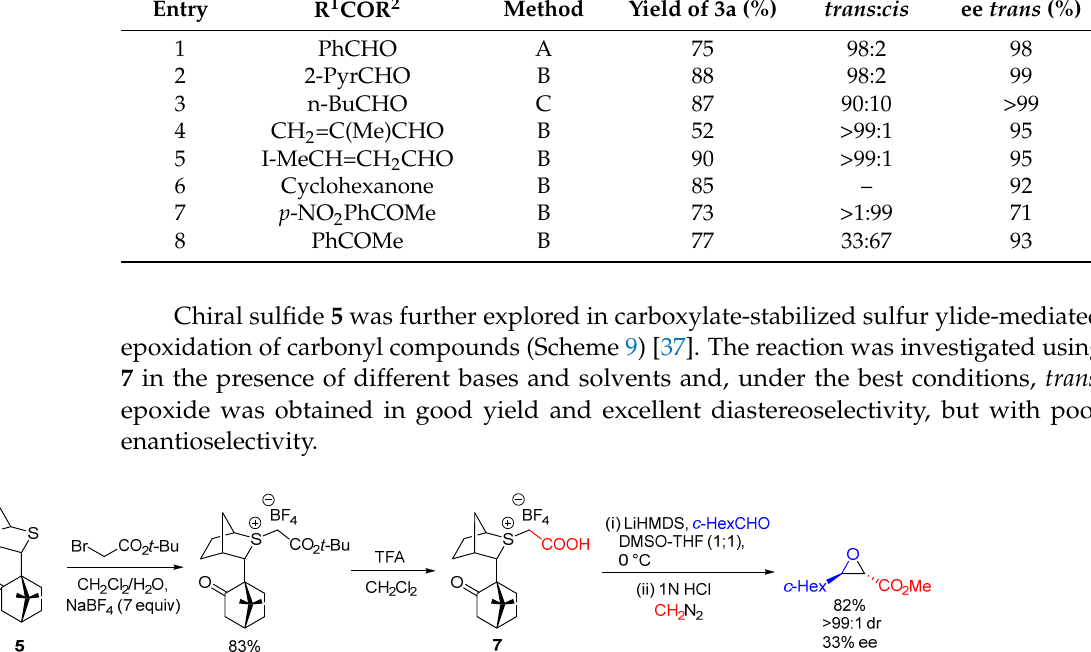
Table 2. Aggarwal asymmetric synthesis of epoxides using sulfonium salt 6 (Scheme 8). Entry R 1 COR 2